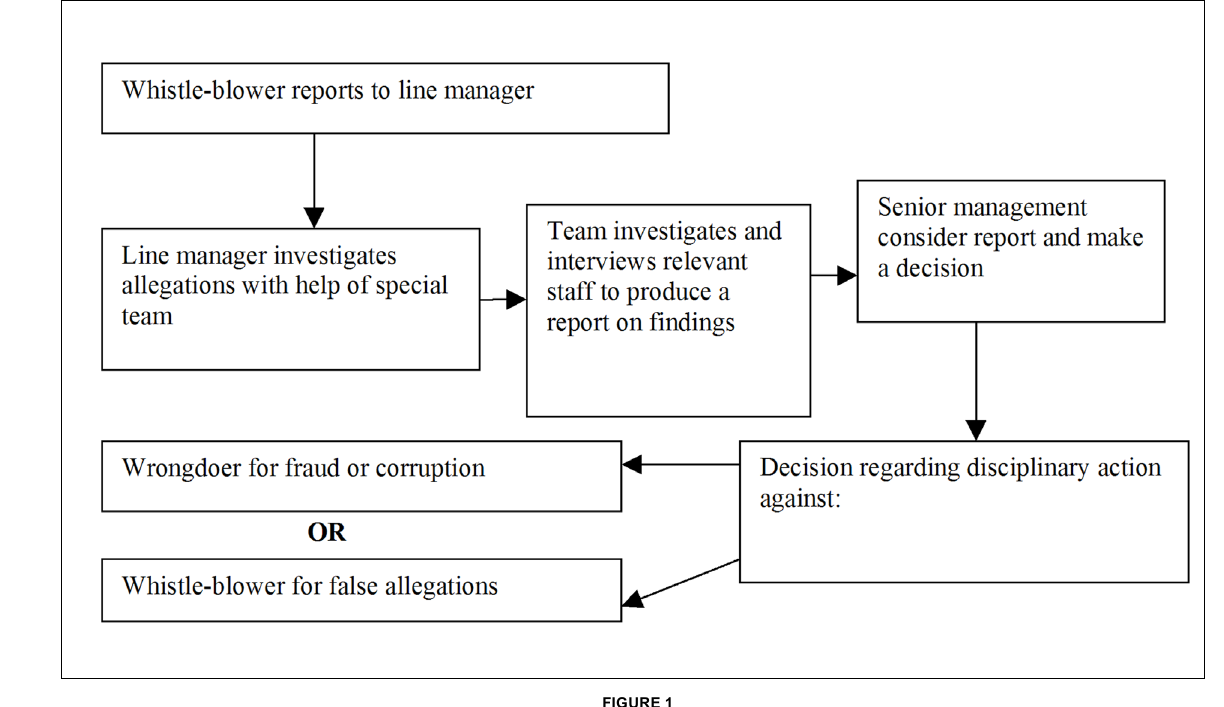
figure 1 Whistle-blowing process* *Source: Adapted from Royal Kingston